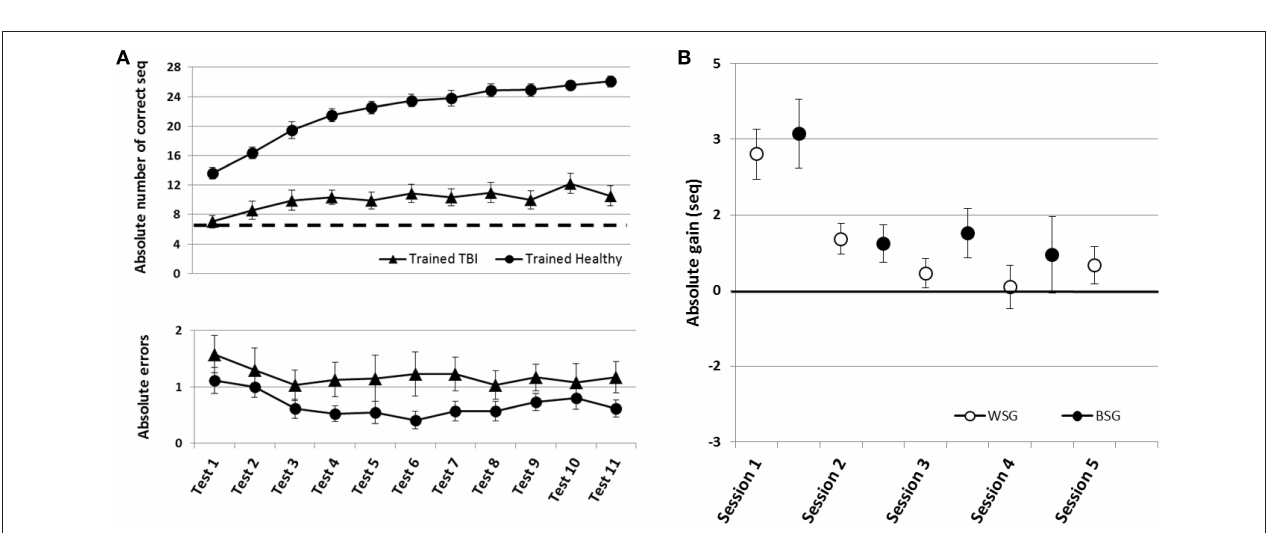
FIGURE 5 | Time-course of improvement across the multi-session training period. Triangles–Trained TBI group, Circles–Trained Healthy group. (A) Speed and accuracy of performance. Upper panel–speed, group average of the absolute number of correct sequences at each of the 11 performance tests. Double arrow–Session. Lower panel–accuracy, group average of the number of incorrect sequences performed at each test. (B) Absolute within-session and between-sessions gains in performance speed of the Trained Healthy group, as in Figure 2 .